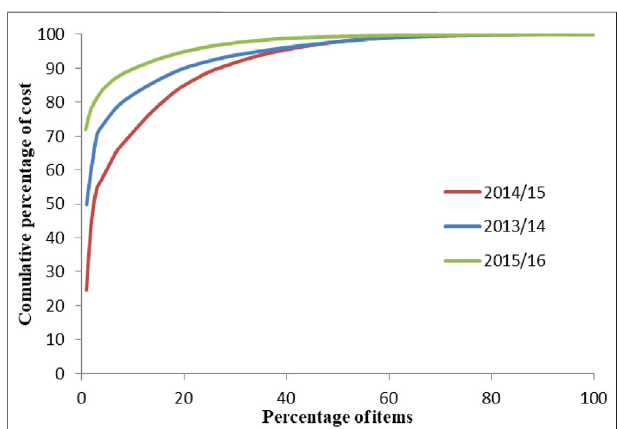
FIGURE 5 | ABC analysis curve of medical supplies in SPHMMC (2013/ 14 – 2015/16), March 2017.